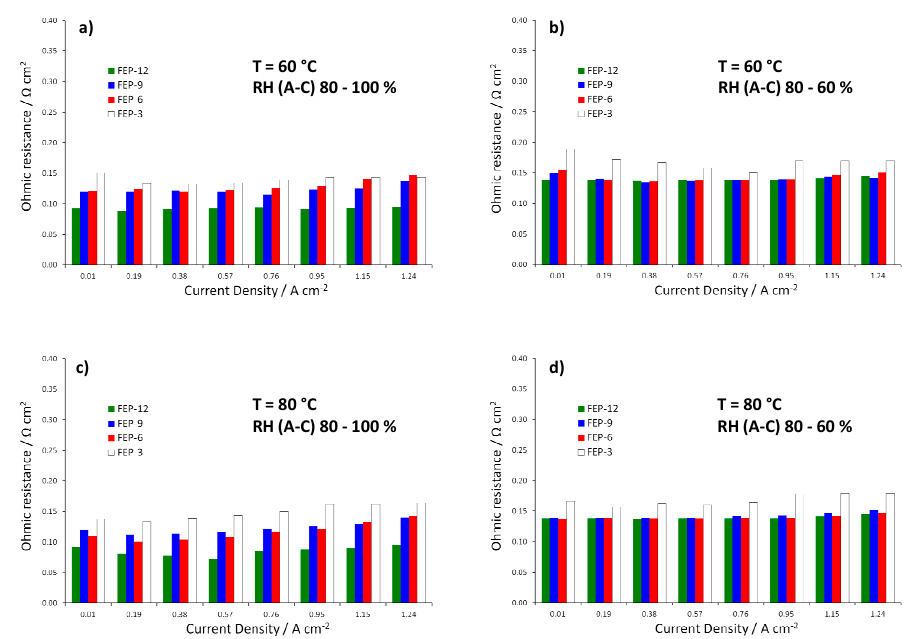
Figure 4. Trend of ohmic resistances (i.e., high frequency resistances, HFRs) obtained from EIS measurements for fuel cells assembled with all the prepared GDMs. Operating conditions: ( a ) 60 °C, RH (A-C): 80–100%; ( b ) 60 °C, RH (A-C): 80–60%; ( c ) 80 °C, RH (A-C): 80–100%; and ( d ) 80 °C, RH (A-C): 80–60%.